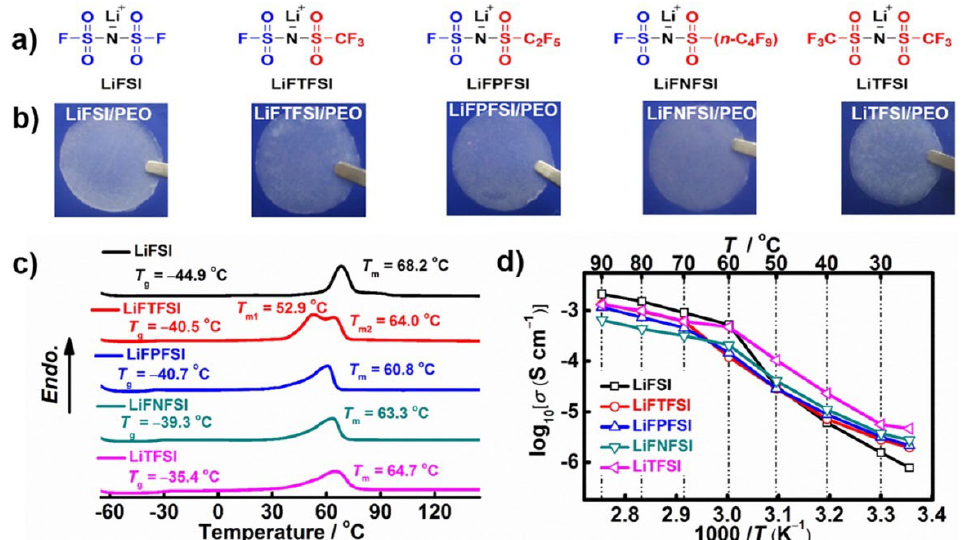
Figure 3. Chemical structures of LiX ( a ), and photographs ( b ), phase behaviors ( c ), and ionic conductivities ( σ ) ( d ) of solid polymer electrolytes of LiX/PEO (X = FSI, FTFSI, FPFSI, FNFSI, and TFSI; [EO]/[Li + ] = 20, by mol). Reproduced with permission from ref. [24]. Copyright 2020 Elsevier.